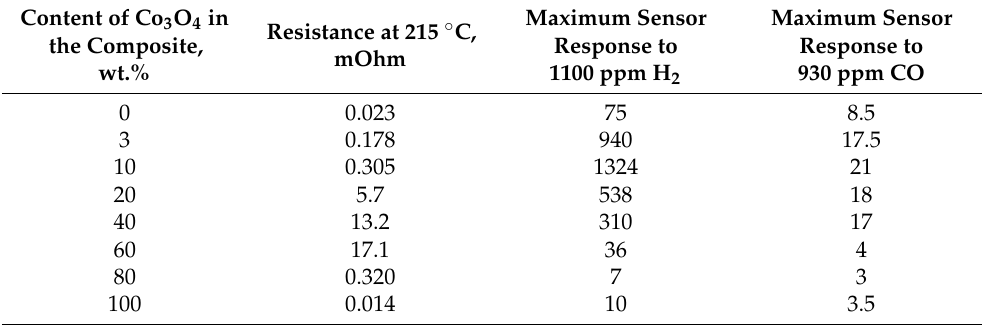
Table 1. Resistance and maximum sensor response of Co 3 O 4 –In 2 O 3 composites to 1100 ppm H 2 and 930 ppm